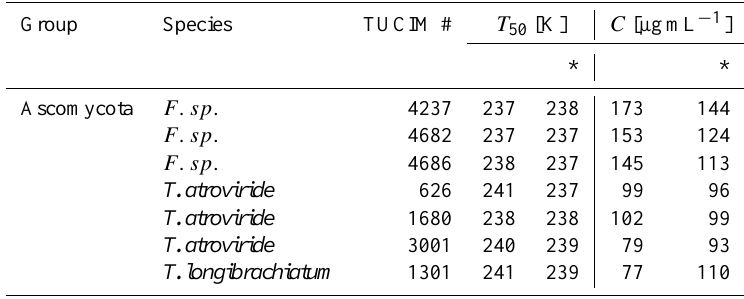
Table 3. A list of T 50 values and total protein concentrations ( C) for Ascomycota spores cultivated under different conditions. Columns marked with an asterisk show results of cultures that were exposed to freezing stress during growth. No error bars were given for C , because it was only 1–2µgmL − 1 with the exception of strain number 626, where it was 4–5µgmL − 1 .